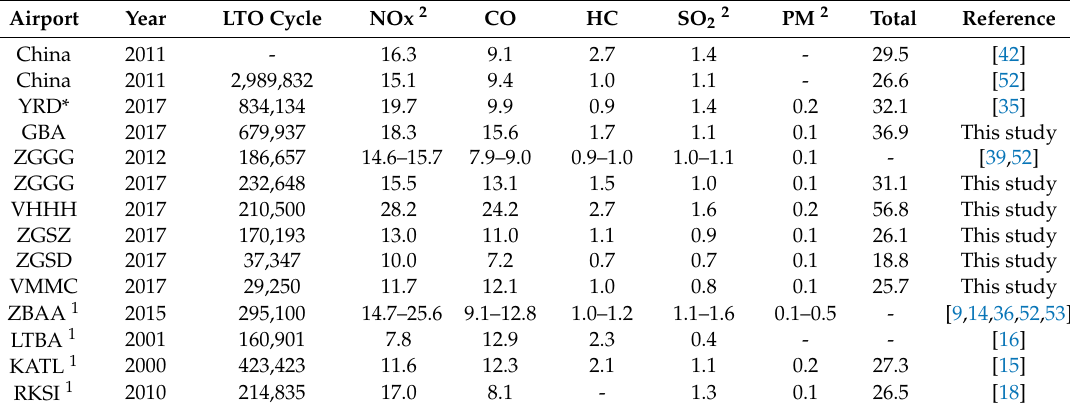
Table 4. Calculated aircraft emissions factors at the five major airports in GBA in 2017 compared with other airports (kg /